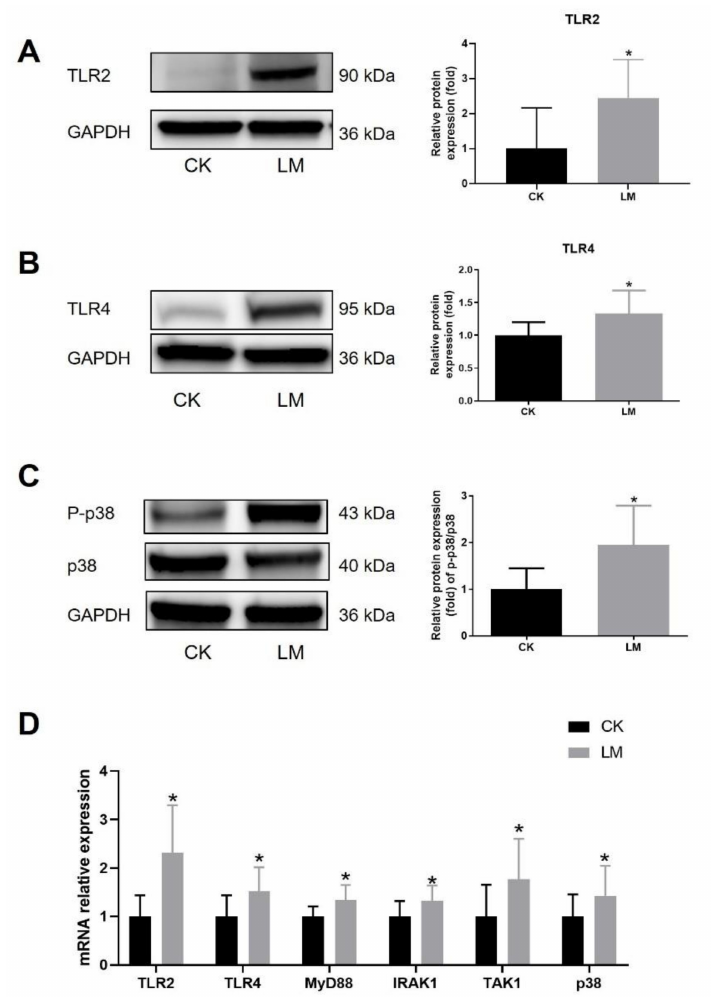
Figure 3. The increase in components in TLR2/4 signaling pathways upon L. monocytogenes infection in mice. ( A – C ) Western blot of TLR2, TLR4 and P-p38/p38 in the jejunum. ( D ) mRNA levels of TLR2 , TLR4 , MyD88 , IRAK1 , TAK1 and p38 from homogenized jejunum samples. * p <